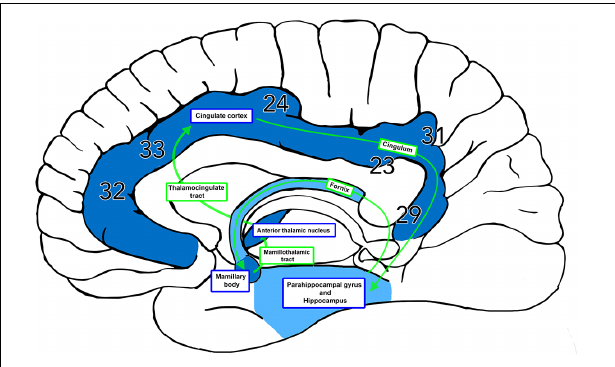
FIGURE 1 | The Papez Circuit. The thalamocingulate tract connects the anterior thalamic nuclei through the cingulate cortex in the cingulum, then travels in a circuit through the parahippocampal gyrus and hippocampus, fornix, mammillary bodies, and mammillothalamic tract back to the anterior cingulate gyrus. Brodmann areas (BA) 32, 33, and 24 correspond to the anterior cingulate cortex. BA 23 and 31 correspond to the posterior cingulate cortex. BA 29 corresponds to the restrosplenial